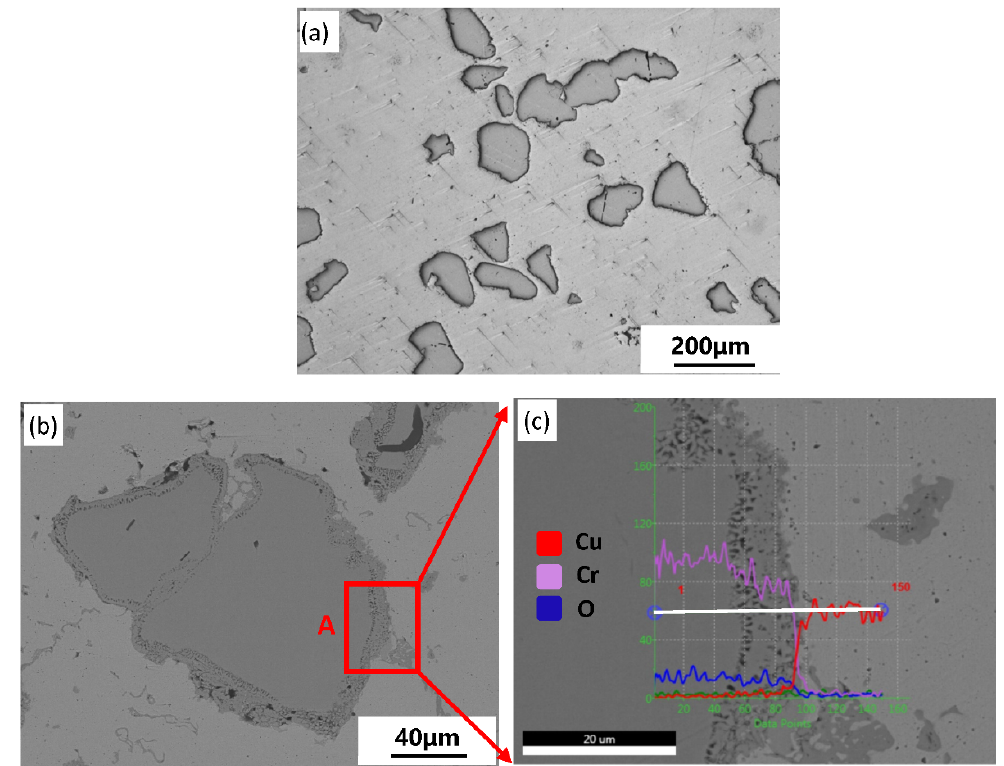
Figure 5. Microstructure of the Cu–Cr sample and interface characteristics. ( a ) Microstructure of the Cu–Cr sample (A2); ( b ) enlarged image of the Cr friction component; ( c ) characteristics of the Cr/Cu interface.